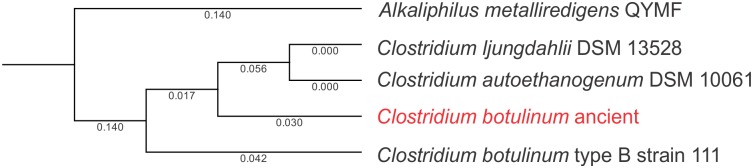
Phylogenetic reconstruction of ancient and extant C. botulinum type B strain 111 plasmid integrase, and plasmid integrases corresponding to Alkaliphilus metalliredigens QYMF, C. ljungdahlii DSM 13528, and C. autoethanogenum DSM 10061.Analyses were performed using maximum likelihood phylogeny using Neighbor Joining, and Jukes Cantor distance with bootstrap resampling (100 replicates). Branch lengths are shown.